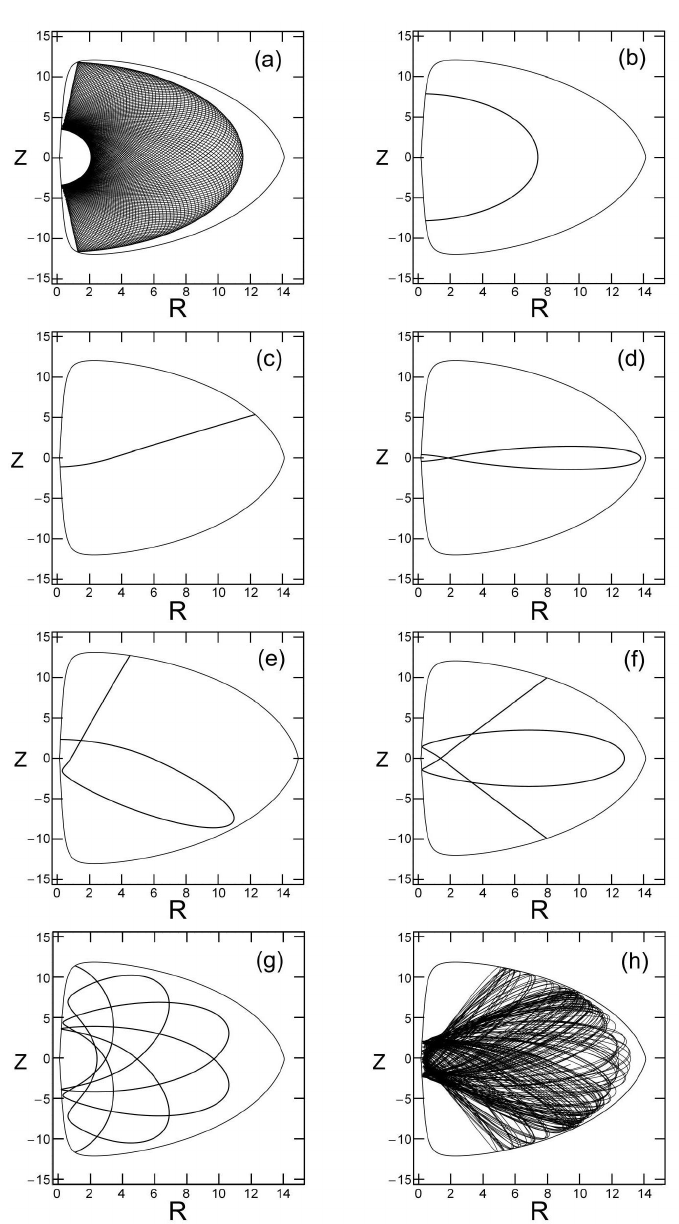
Fig. 3. Orbit collection of the basic types of orbits in our galaxy model: (a) box orbit; (b) 2:1 banana-type orbit; (c) 1:1 linear orbit; (d) 2:3 fish-type orbit; (e) 3:2 boxlet orbit; (f) 4:3 boxlet orbit; (g) 10:7 boxlet orbit, one of our “orbits with higher resonance”; (h) chaotic orbit. R and z are the cylindrical